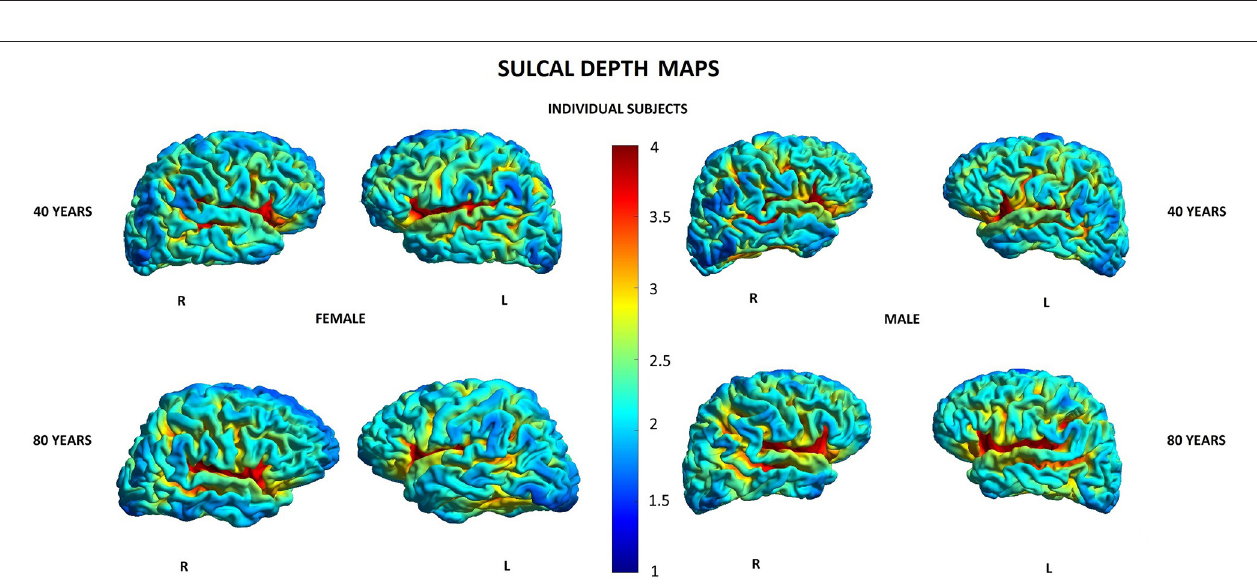
FIGURE 5 | Cortical maps of age-related distribution of sulcal depth in 40- and 80-year-old female and male individual subjects. Lateral views of right (R) and left (L) hemispheres.